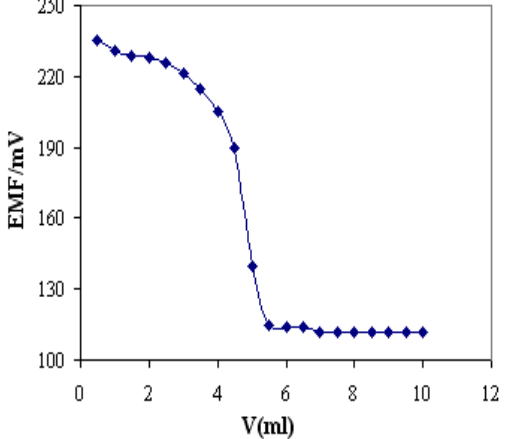
Fig. 5. The plot of potential vs pH of MWCNT-modified carbon paste mercury electrode at 8.0×10 -5 mol L -1 Hg 2+ .